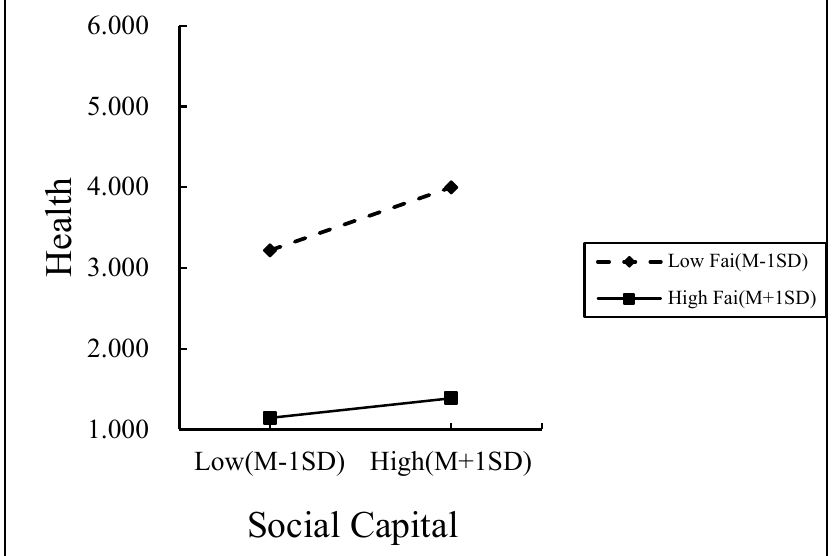
Figure 2. The moderating role of family care in the relationship between social capital and health.